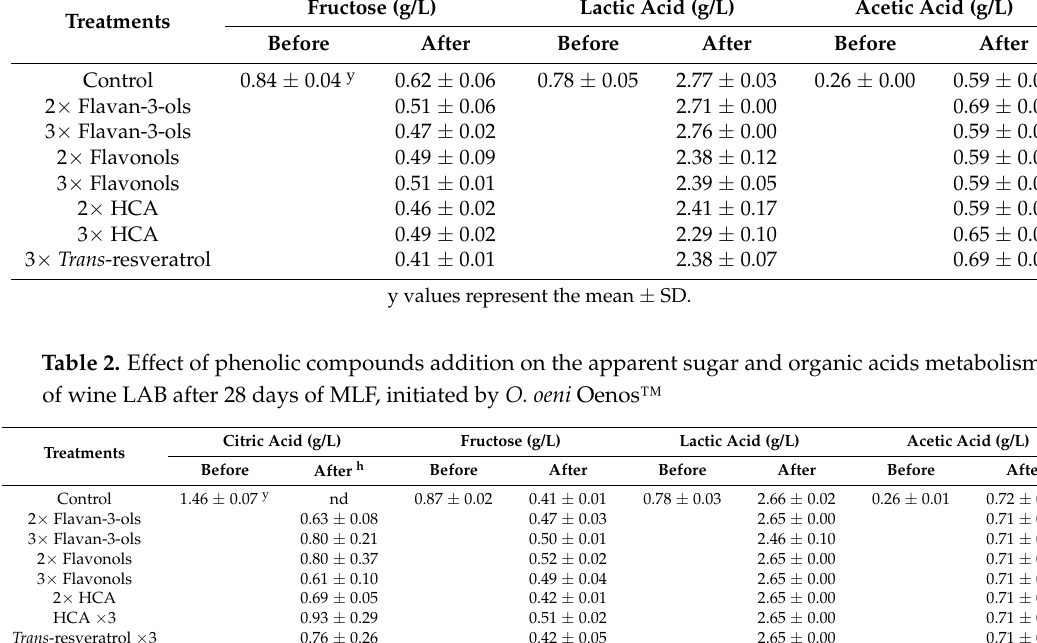
Table 1. Effect of phenolic compound addition on apparent sugar and organic acid metabolism of wine lactic acid bacteria (LAB) after 28 days of spontaneous malolactic fermentation (MLF). Fructose (g/L) Lactic Acid (g/L) Acetic Acid (g/L) Treatments Before After Before After Before After